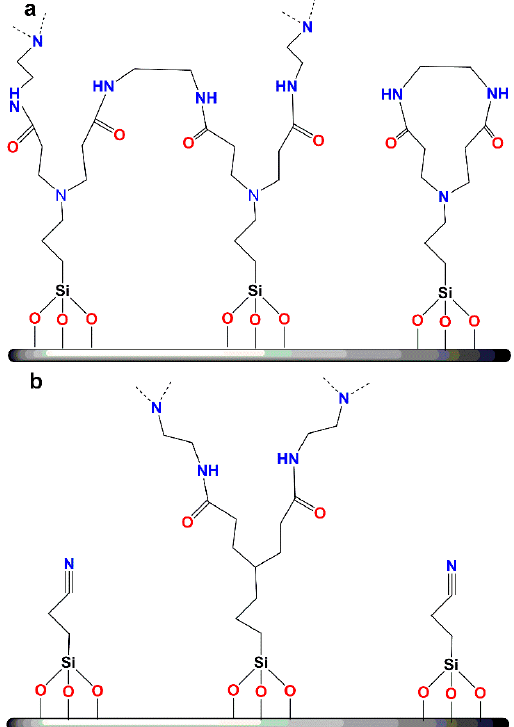
Figure 26. ( a ) Common structural defects occurring during the dendron propagation reaction; ( b ) introduction of triethoxysilyl propylonitrile as a spacer for the elimination of cross-linking structural defects (Reproduced with permission from [96]; Copyright American Chemical Society, 2004).